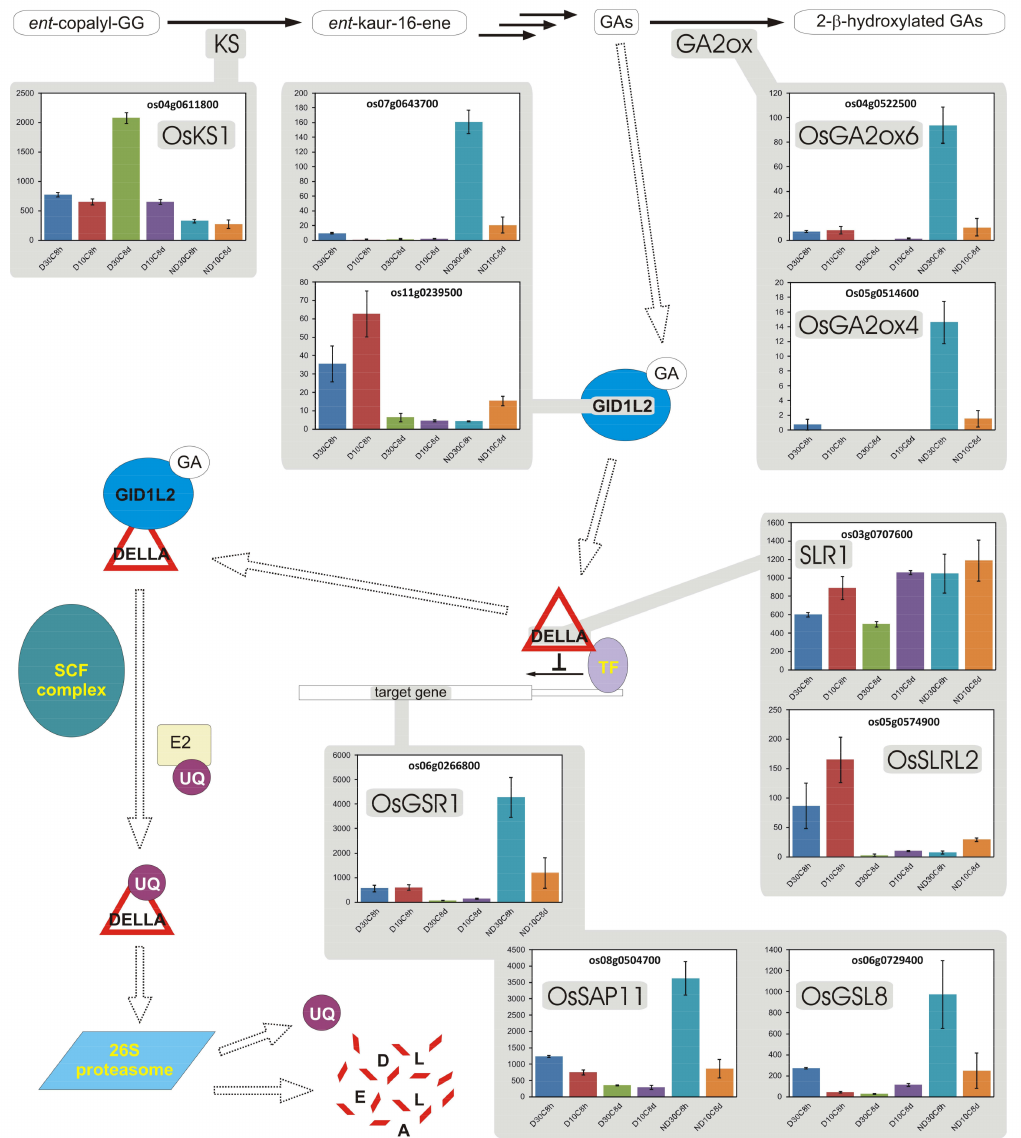
Figure 8. Expression levels (left scale on the y-axis of each plot) of DEGs involved in gibberellin (GA) metabolism, regulation and signaling pathways. Metabolism of GA (dark arrows): the first step dedicated to GA synthesis is catalyzed by ent-kaurene synthase (KS, plastidic); then, through several steps (in the endoplasmic reticulum and finally in the cytoplasm) bioactive GAs are produced. GA 2-oxidases (GA2ox) catalyze 2 β -hydroxylation of GAs, which are thereby deactivated. GA signaling (white dotted arrows): bioactive GAs are perceived by GIBBERELLIN-INSENSITIVE-DWARF-1-like type-2 putative receptors (GID1L2), which then interact with specific transcriptional repressors called DELLA (like SLR1, or its functionally cognate GRAS factor OsSLRL2, which lacks the DELLA domain) and promote their ubiquitination (with multiple transfers of ubiquitin, UQ, from the ubiquitin-conjugating enzyme E2) by activating an E3 ubiquitin ligase protein complex (SCF complex). Ubiquinated DELLA proteins are then degraded via the 26S proteasome. If not degraded, DELLA repressors stop transcription of GA-responsive genes. On the other hand, degradation of DELLA repressors leads to the release of repression and expression of target genes (like OsGSR1 , OsGSL8 and OsSAP11 ). Error bars represent standard errors ( n = 3 repeats for each